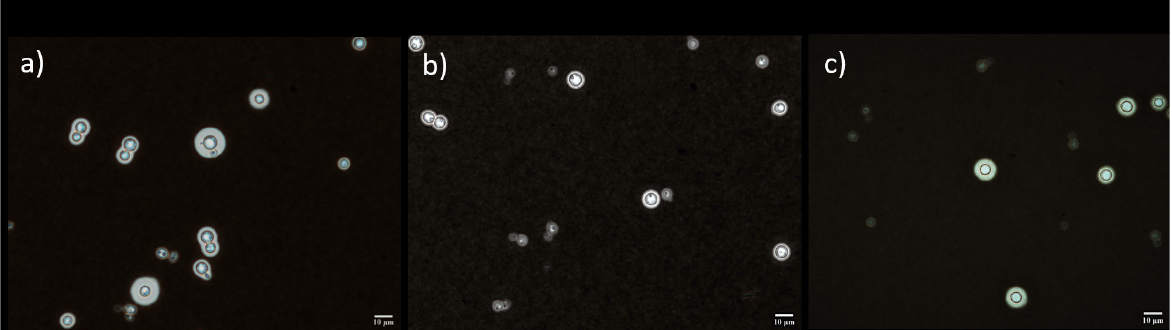
Figure 2. Effect of DH on the polysaccharide capsule size of C. neoformans . C. neoformans cells were stained with Chinese ink and analyzed with a magnification of 400x. a) Control. b) DH at the minimal subinhibitory concentration (Sub-MIC) of 9.28 μg / mL. c) DH in synergistic concentrations (1.16 μg/mL and FLZ 1 μg /mL). DH: duloxetine hydrochloride; FLZ: fluconazole; Control: C. neoformans ATCC H99 5x10 6 cells